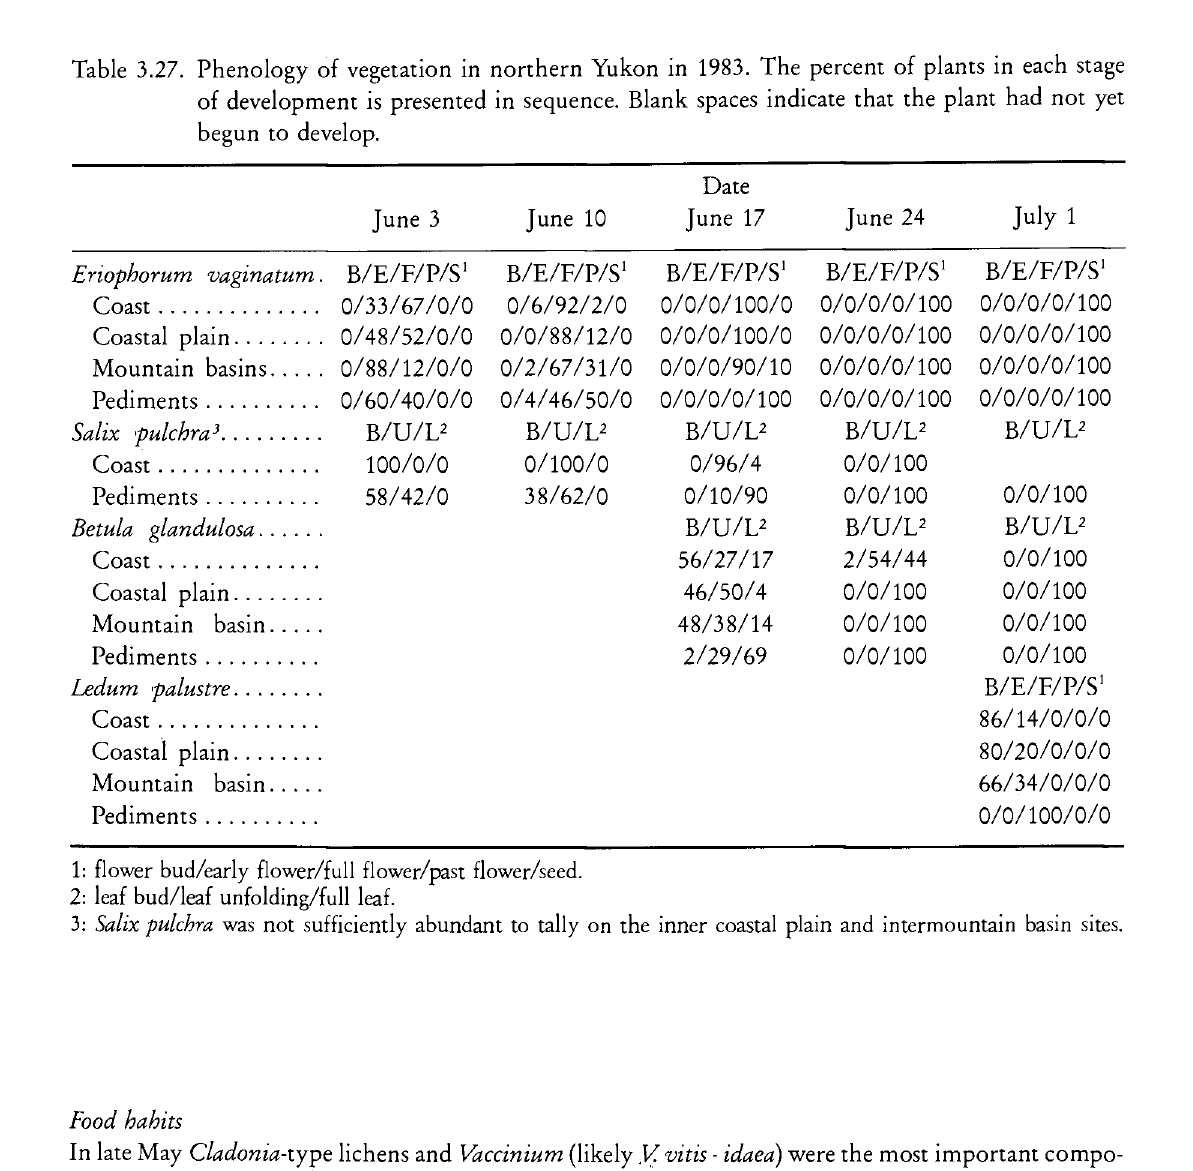
Table 3.27. Phenology of vegetation in northern Yukon in 1983. The percent of plants in each stage of development is presented in sequence. Blank spaces indicate that the plant had not yet begun to